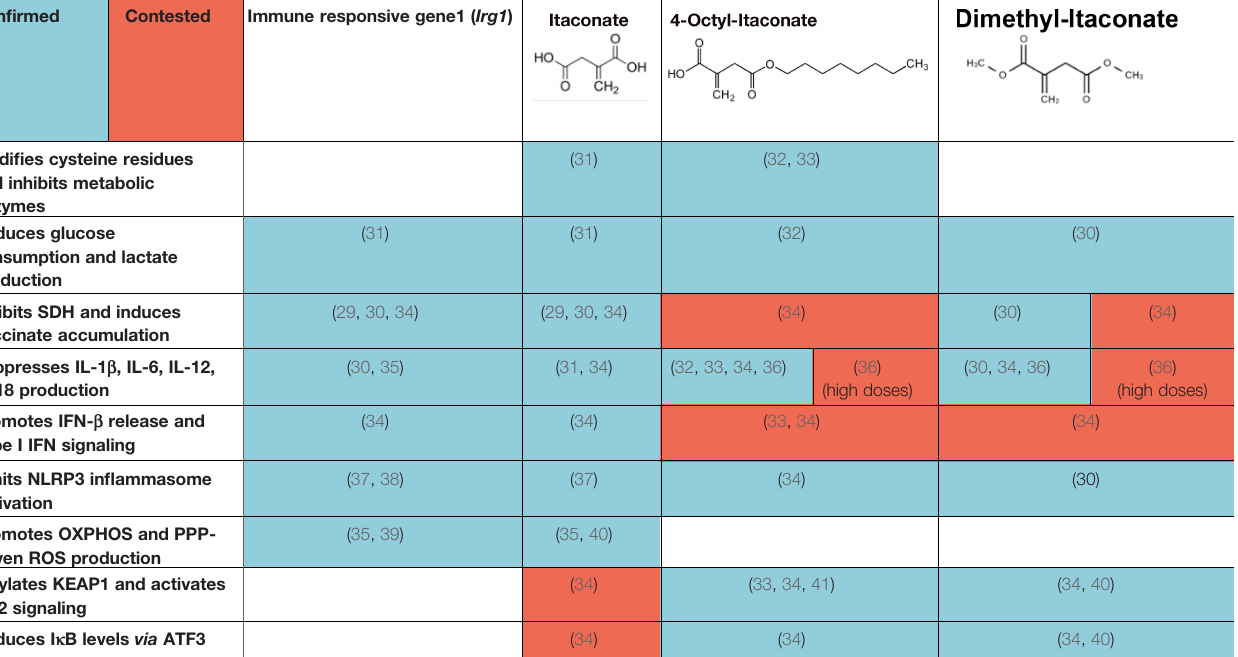
TABLE 1 | Mechanisms of action of itaconate, and its